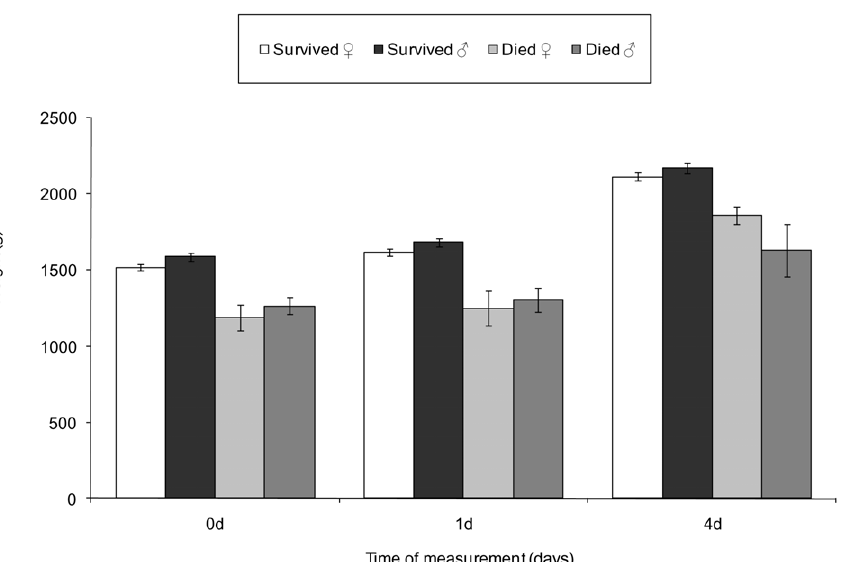
Figure 1. Plot of mean weights ( ± SE) illustrating differences between females ( R ) and males ( = ) that survived to weaning (Survived) and died before weaning (Died) in body weight at birth (0 d), one day (1 d) and four days (4 d) after birth. LMM analysis shows that sex and mortality significantly affect average weight across time (see text for details).